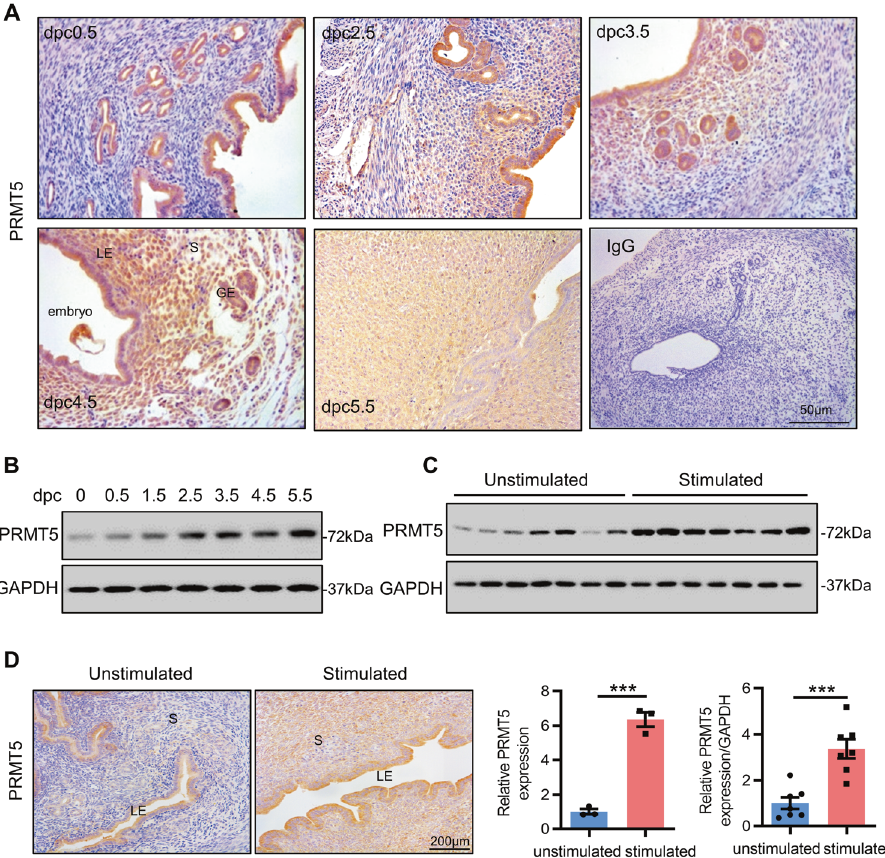
Fig. 2 Endometrial stromal PRMT5 expression increases upon decidualization in mice. A IHC analysis of PRMT5 in the uterus at 0.5 – 5.5 days postcoitum (dpc) of pregnancy, scale bar = 50 µm. B Western blot analysis of PRMT5 expression in the uterus at 0.5 – 5.5 dpc of pregnancy. C Western blot analysis of PRMT5 expression in the stimulated and unstimulated uteri in an arti fi cially stimulated decidualization mouse model ( n = 7). D IHC analysis of PRMT5 in the stimulated and unstimulated uteri in an arti fi cially stimulated decidualization mouse model ( n = 3), scale bar = 200 µm. LE luminal epithelium, GE, glandular epithelium, S stroma. Means ± SEM. *** P < 0.001, Student ’ s t